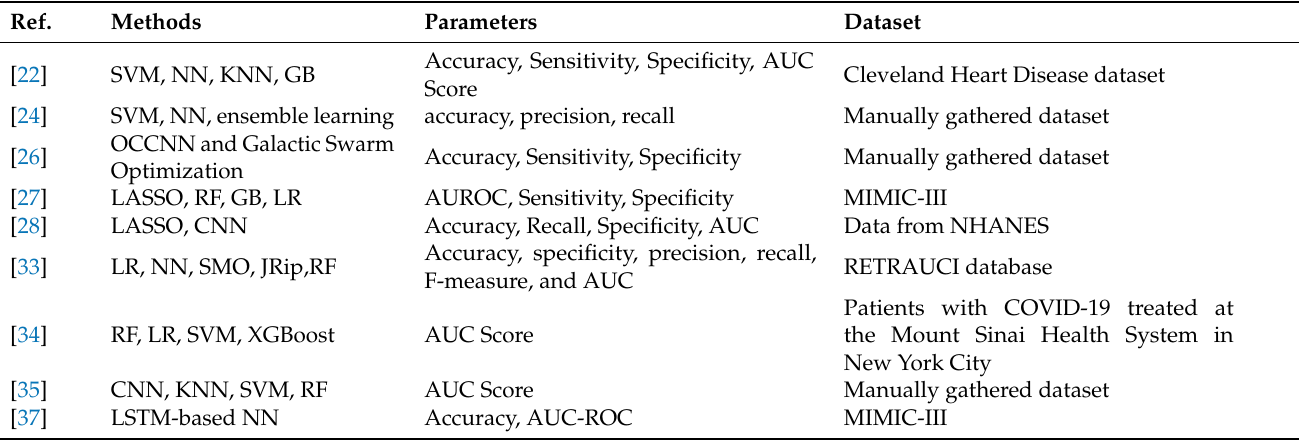
Table 1. Theoretical comparison of different